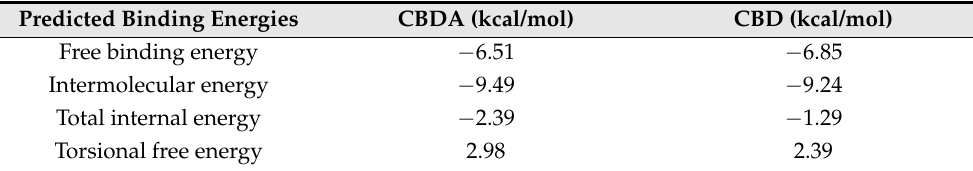
Table 5. Binding energies between CBDA or CBD and the M pro protein predicted by the molecular docking